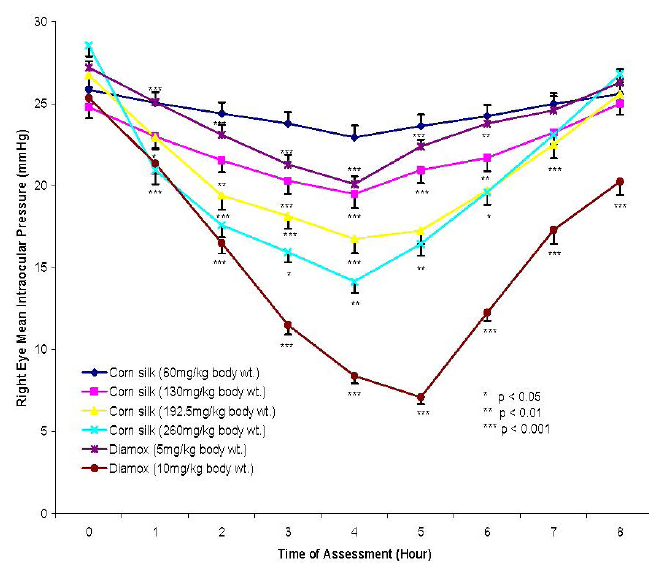
Figure 5 : Mean IOP response to varied doses of CSAE compared to acetazolamide (Diamox) in ocular hypertensives. The IOP response to 10 mg/kg body wt. of acetazolamide was most